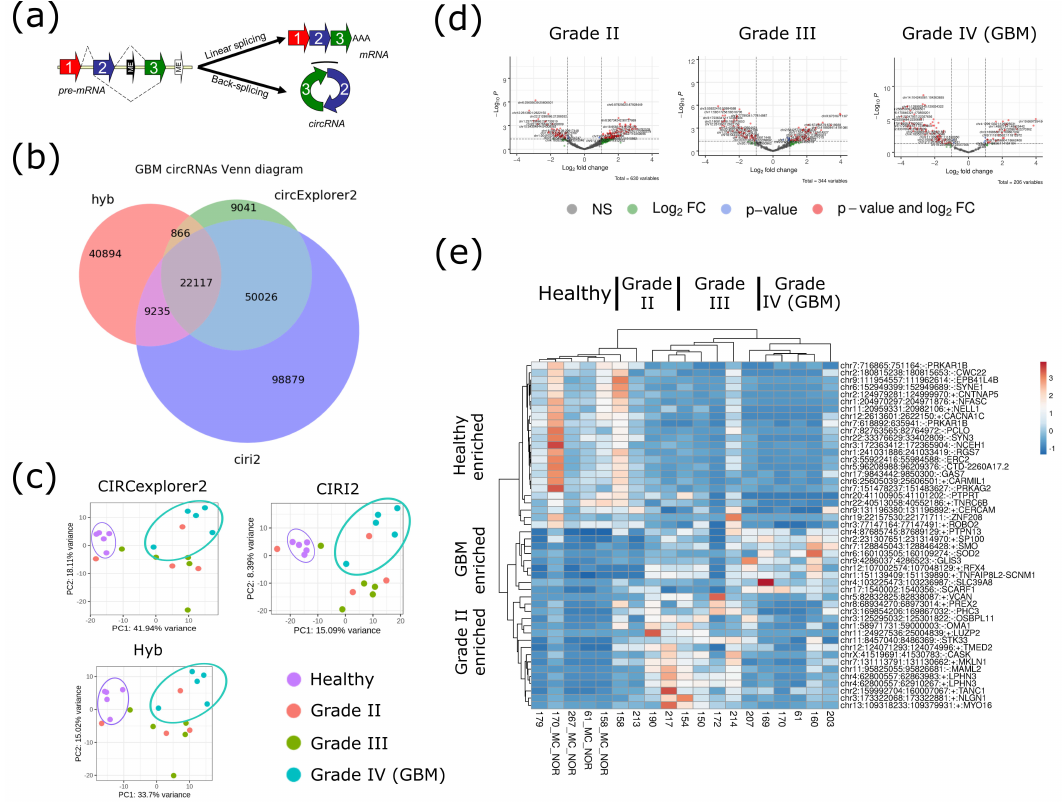
Figure 1. Circular RNA (circRNA) profiling of human gliomas can stratify glioblastoma (GBM) tumors. ( a ) Canonical linear splicing versus non-canonical, back-splicing producing mRNA and circRNA, respectively. Arc highlights the location of the backsplice junction. ( b ) Scaled Venn diagram showing total number of circRNAs identified from all 19 brain, circRNA-seq libraries using three di ff erent circRNA identification pipelines, CIRCexplorer2, CIRI, and Hyb. ( c ) Two-dimensional PCA plot utilizing circRNA-seq output from CIRCexplorer2 on 19 samples across healthy, grade II, III, and IV (GBM) gliomas. Ellipses included to highlight stratification of healthy tissue (purple) and grade IV tumor (blue) for each of the three circRNA prediction pipelines. ( d ) Expanded volcano plot showing circRNAs regulated between healthy tissue and grade II (left panel), grade III (middle panel) and grade IV, GBM (right panel). ( e ) Heat map showing representative examples of circRNAs specific to healthy brain tissue, grade-specific (grade II and grade IV (GBM)) using CIRCexplorer2. The color scale bar represents the log-transformed normalized